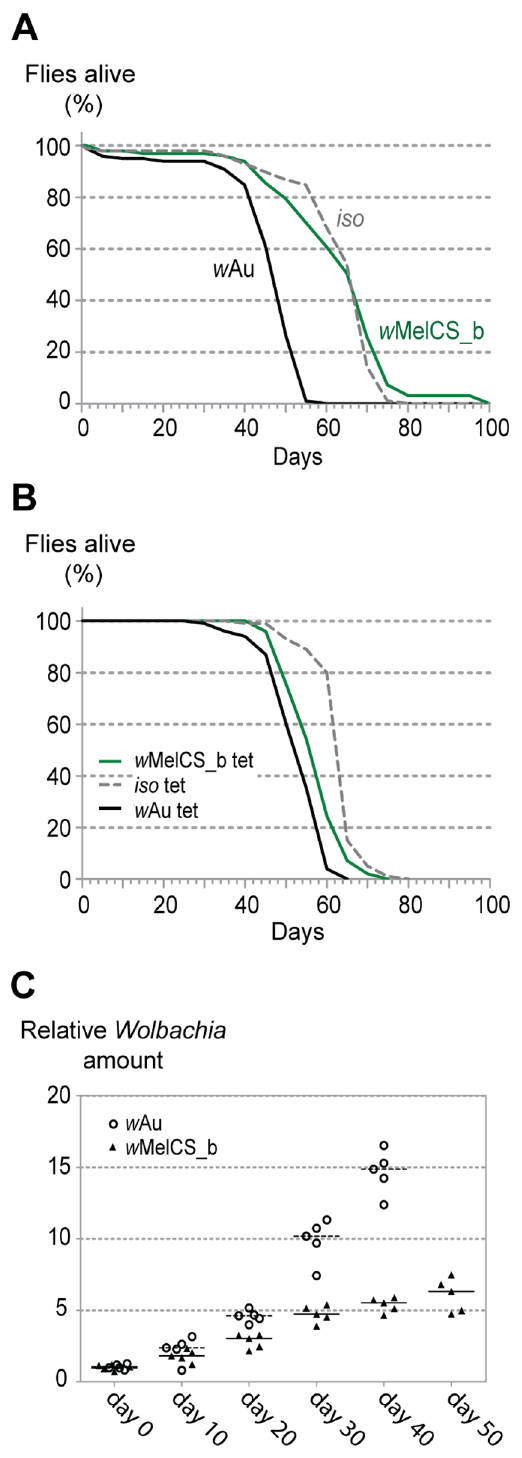
Figure 2. w Au shortens the lifespan of the flies and grows exponentially within the hosts. (A) The survival of one hundred Wolbachia -free iso , w Au and w MelCS_b carrying male flies was checked every five days. The experiment was repeated once with comparable results and analysis was performed on both repetitions (Figure S1E). (B) The survival of one hundred males derived from iso , w Au and w MelCS_b tetracycline-treated stocks was checked every five days. The experiment was repeated once with comparable results and analysis was performed on both repetitions (Figure S1F). (C) qPCR